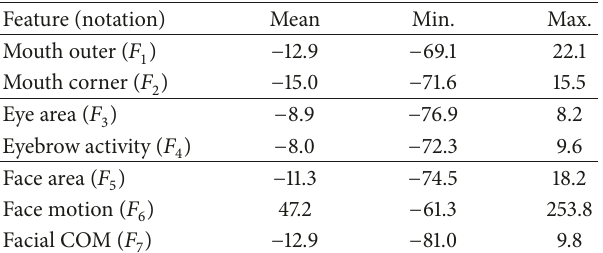
Table 3: Percentage of change of features from period 𝐻 0 to 𝐻 1 in the Mushroom game ( 𝑁 = 20 ).